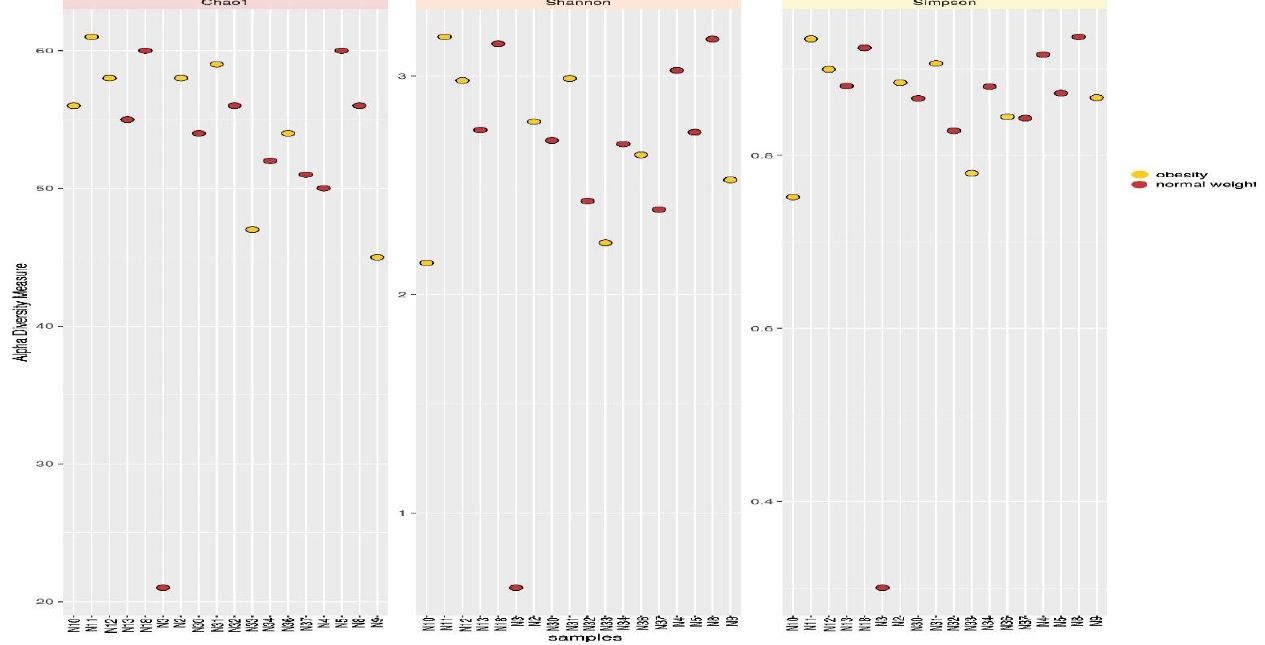
Figure 4. Chao, Shannon and Simpson indexes used to evaluate alpha diversity of the genera. Sample N3 showed more diversity compared to the other samples.